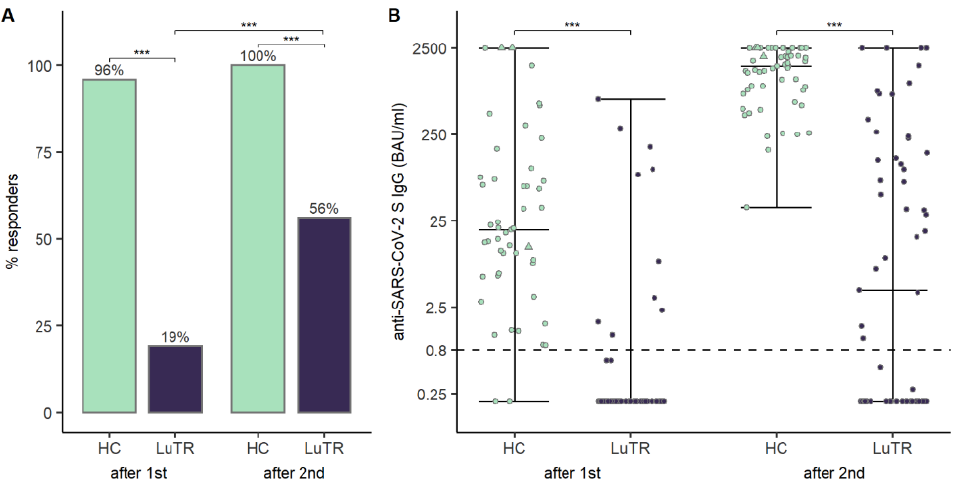
Figure 1. Humoral response after mRNA vaccine in LuTRs and in HCs after the first and second immunization: seroconversion rates of SARS-CoV-2 antibodies and increase in seroconversion rate (% of response) ( A ). SARS-CoV-2 S antibody levels (BAU/mL). Upper level of quantification: 2500 BAU/mL. The horizontal line indicates the cutoff for seroconversion. Circles represent individual antibody levels. Participants with a history of COVID-19, prior to immunization, are represented as triangles ( B ). (*** significant).